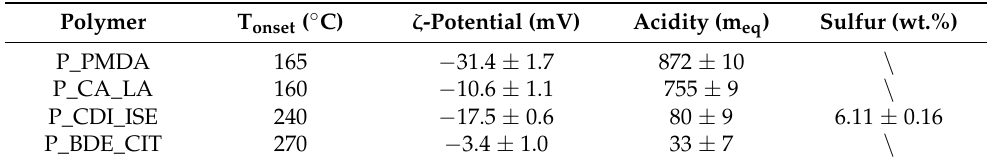
Figure 2. FTIR-ATR spectra of ( A ) P_PMDA, ( B ) P_CA_LA ( C ) P_CDI_ISE, and ( D ) P_BDE_CIT. Table 1. Main characteristics of synthesized